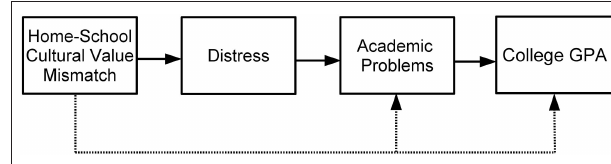
FIGURE 2 | Hypothesized model for consequences of home-school cultural value mismatch. A dashed line indicates a non-significant relation was